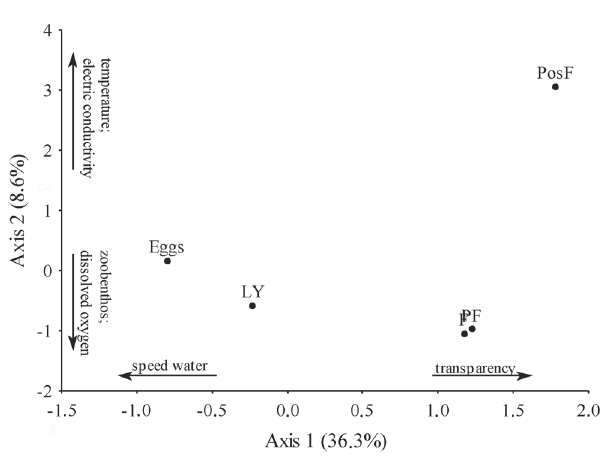
Fig. 10. Canonical correlation analysis relating the abundance of the different larval stages from October 2011 to March 2012. Eggs: eggs; LY: larval yolk; PF: preflexion; F: flexion; PosF: